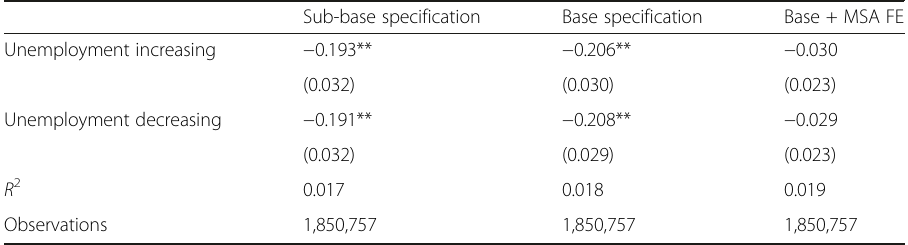
Table 6 Asymmetric response of multiple job holding with respect to unemployment Sub-base specification Base specification Base + MSA FE Unemployment increasing Unemployment decreasing